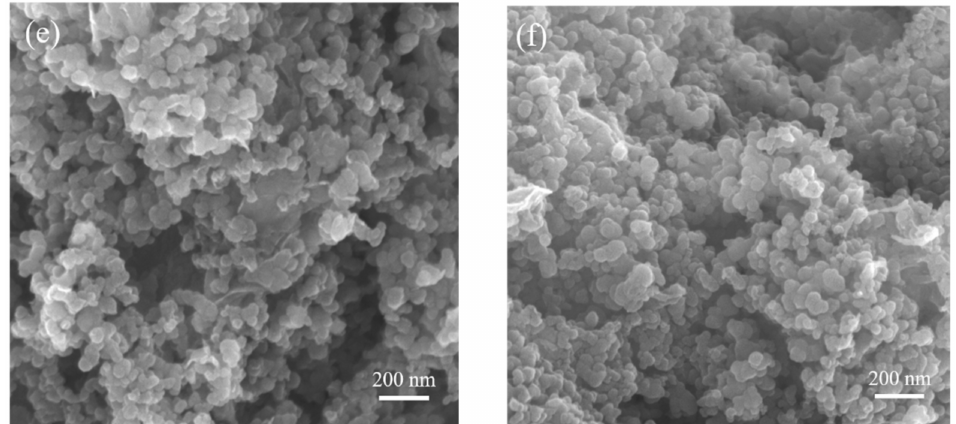
Table 1. Electrochemical comparison of NiCo-based sulfides synthesized by different methods.